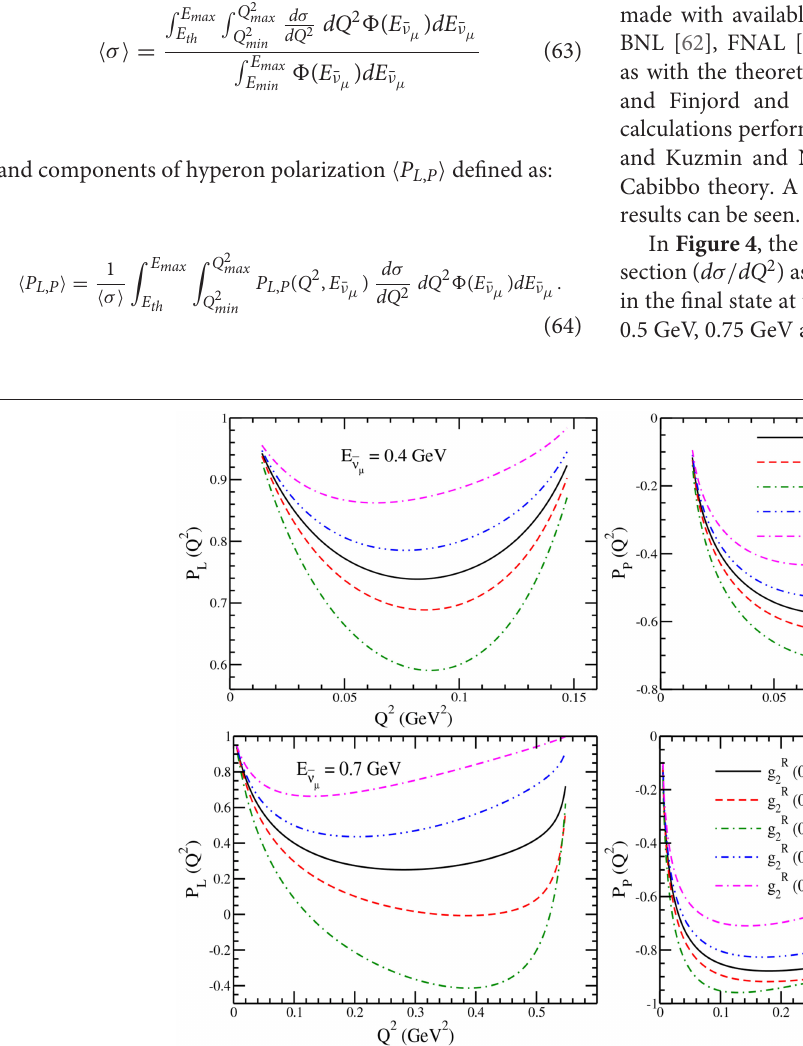
FIGURE 7 | P L ( Q 2 ) (left) and P P ( Q 2 ) (right) for the process line), 3 (dash-dotted line),